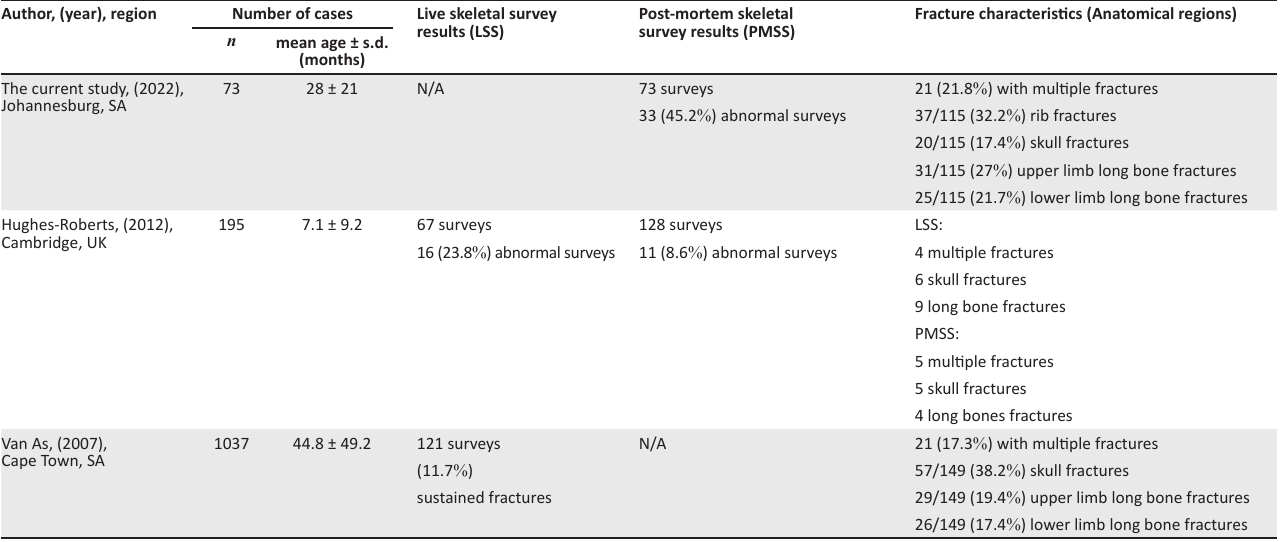
TABLE 4: Comparison between this study’s main findings and key studies. Author, (year),